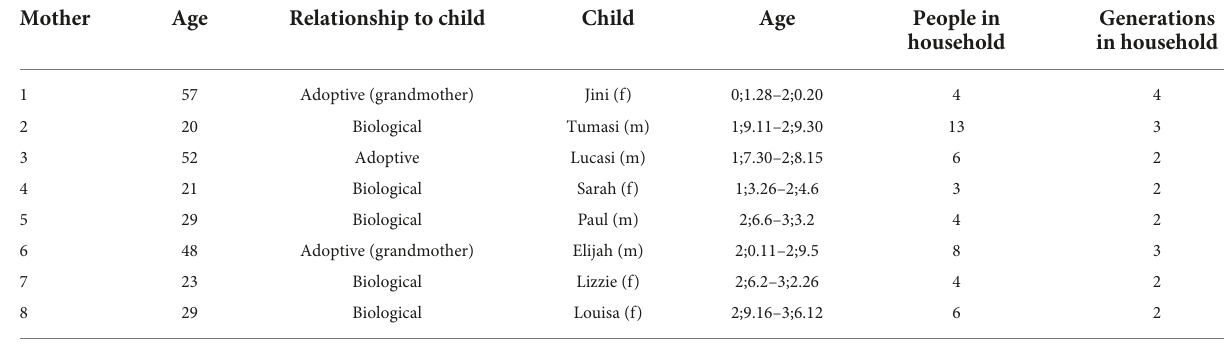
TABLE 2 Data statistics by stage.